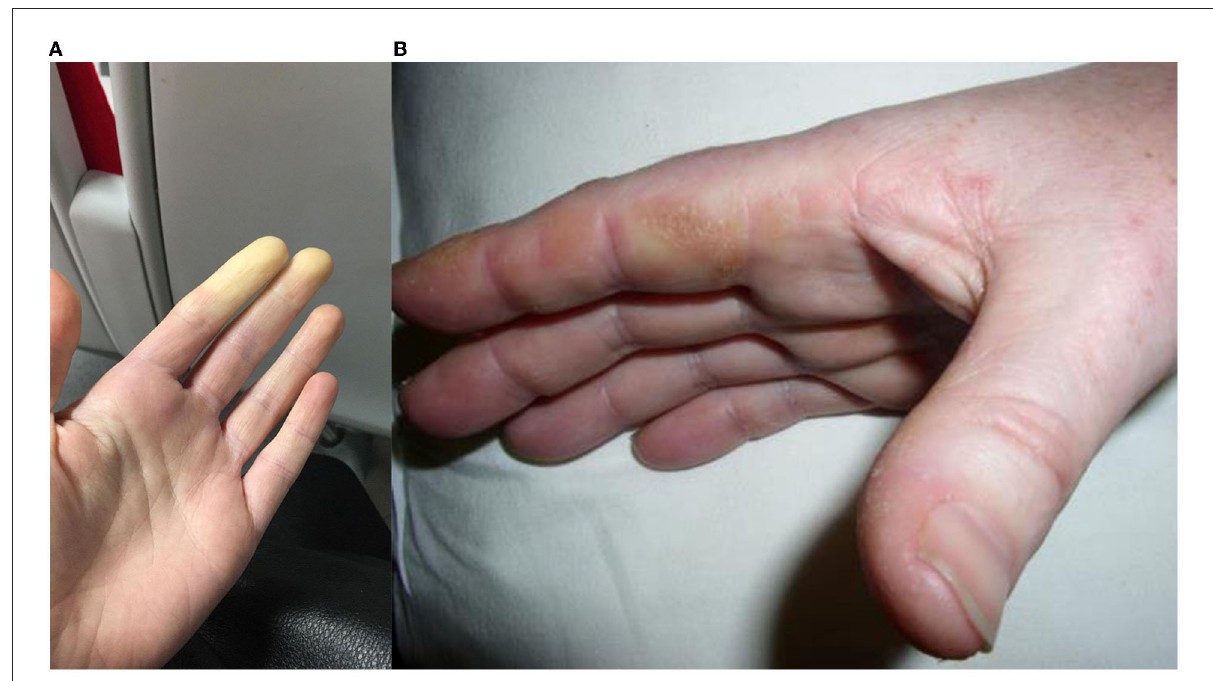
FIGURE3 (A) Raynaud’s phenomenon, initial vasoconstriction causing pallor, which usually progresses to cyanosis then reactive hyperemia in triphasic Raynaud’s; (B) Mechanic’s hands, hyperkeratotic, fissured skin predominantly visible over the radial border of the index finger.